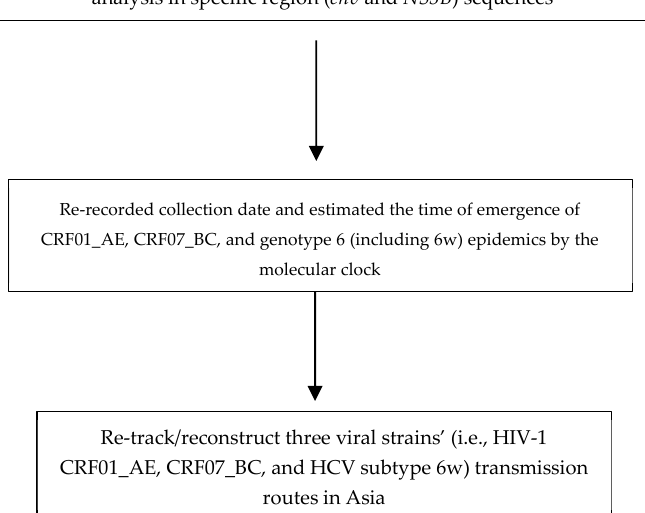
Figure A1. Study flowchart. A total of 1427 Taiwanese PWID blood samples were collected from hospitals, detention centers, and prisons during 2004–2008. Four hundred sequences were used in phylogenetic and evolutionary analyzes.